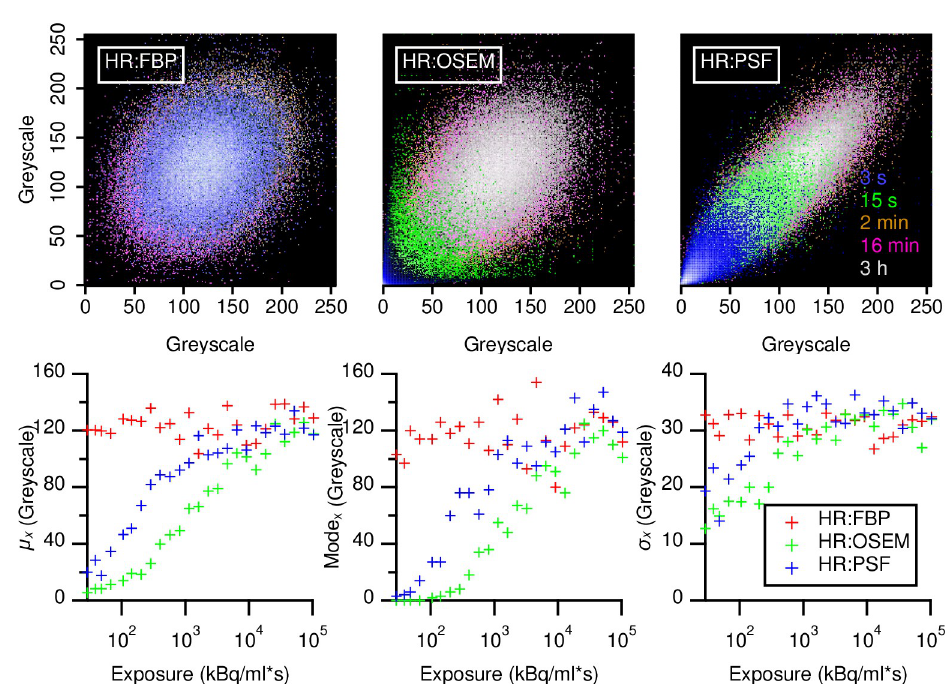
Fig 4. Overlaid examples of 8 bit GLCMs in units of greyscales. GLCMs calculated from HR datasets and reconstructed with either with FBP, OSEM, or TrueX, PSF. Five selected acquisition durations are shown at their location in respect to absolute their greyscale values. GLCM maxima are normalized to unity and are displayed with a logarithmic color scale. Acquisition times are noted besides the PSF GLCM in the respective